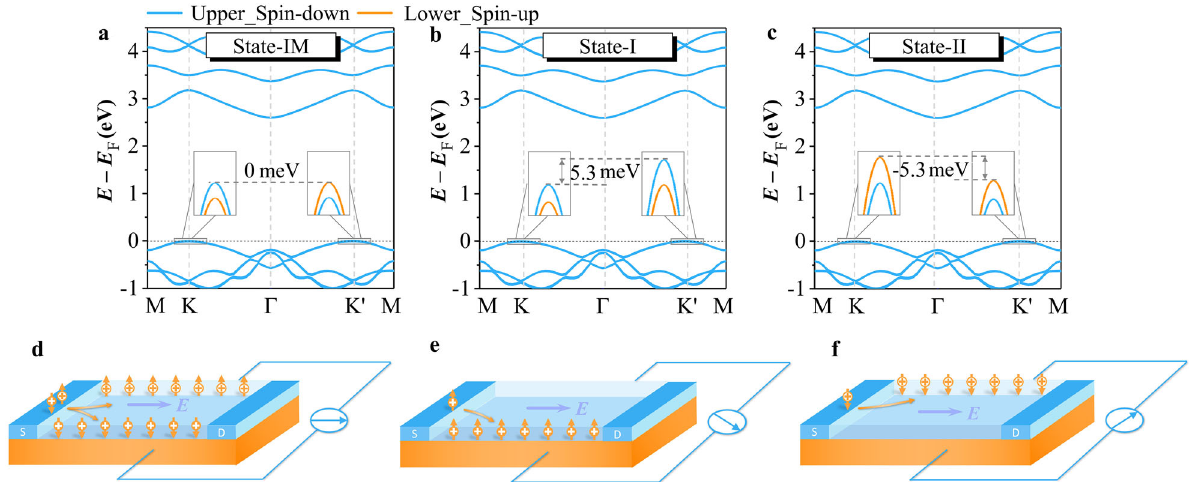
Fig. 3 Band structures and anomalous valley Hall effect or valley Hall effect of bilayer T-FeCl 2 . Band structures of a state-IM, b state-I, and c state-II of bilayer T-FeCl 2 with considering SOC. Insets in a – c show the enlarged bands around the valleys. The Fermi level is set to 0 eV. Diagrams of the anomalous valley Hall effect or valley Hall effect under hole doping for d state-IM, e state-I, and f state-II. The holes from the K and K ′ valleys are denoted by orange + and white + symbols, respectively. Upward and downward arrows refer to the spin-up and spin-down carriers, respectively.